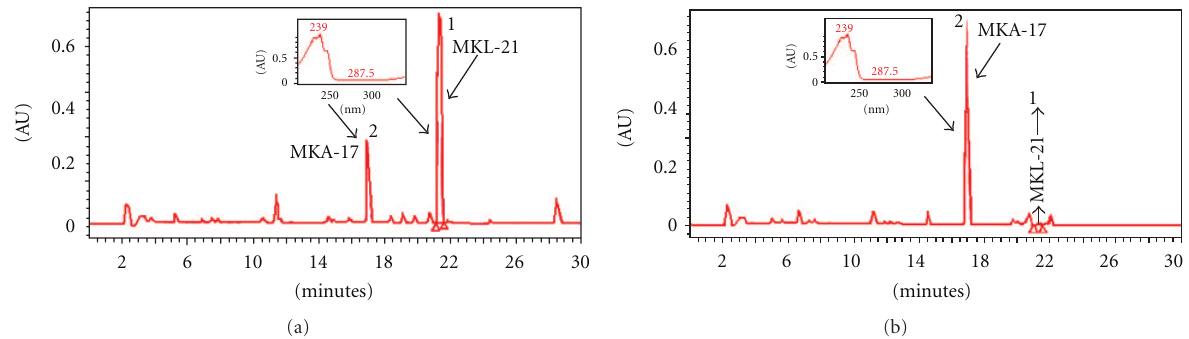
Figure 2: HPLC chromatogram of the supplement-fermented Monascus purpureus Hypocol. (a) Hypocol HPLC chromatogram profile before lactonization and (b) after